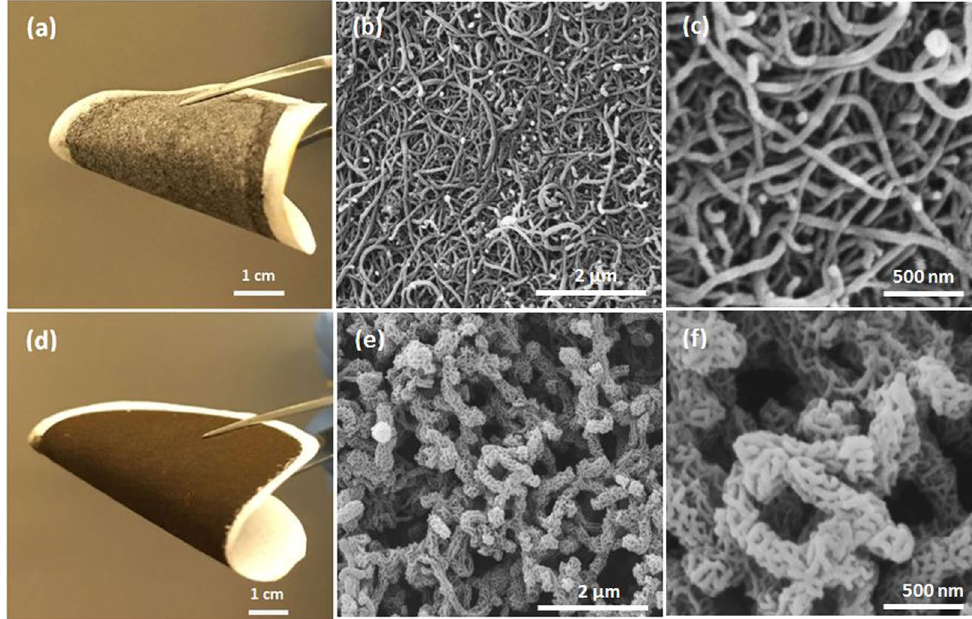
Figure 1. ( a ) Photo of membrane based on MWCNT/cellulose microfibers. ( b ) and ( c ) SEM images of MWCNT coated membrane at different magnifications. ( d ) Photo of membrane based on MWCNT-MnO 2